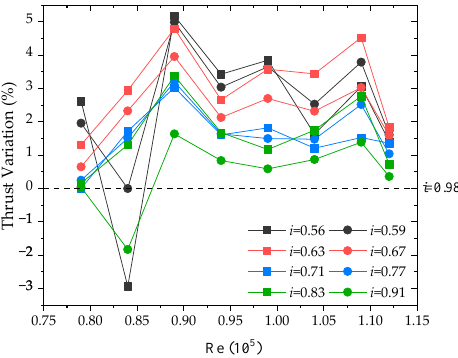
Figure 5. Thrust variation in hover (compared with i = 0.98).